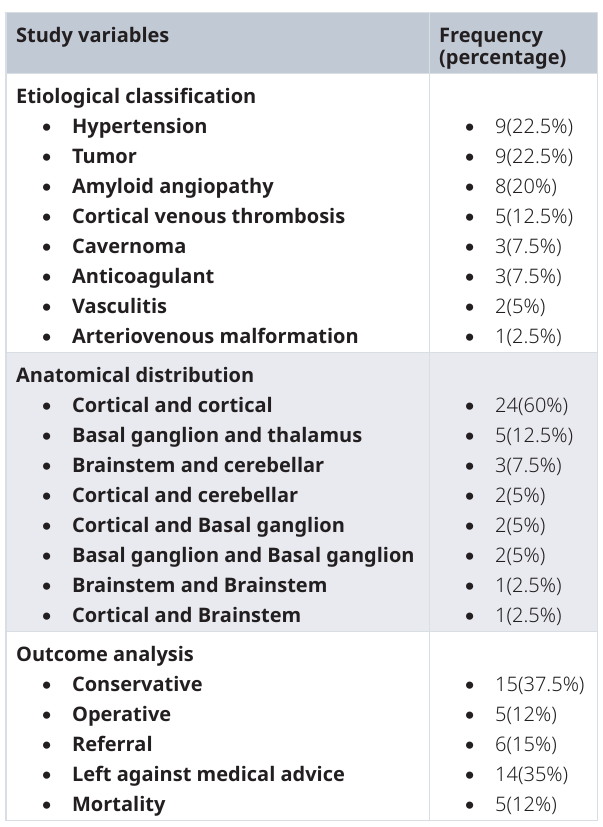
Table 1. Analysis of our cohort presenting with spontaneous simultaneous multiple intracerebral hemorrhages.